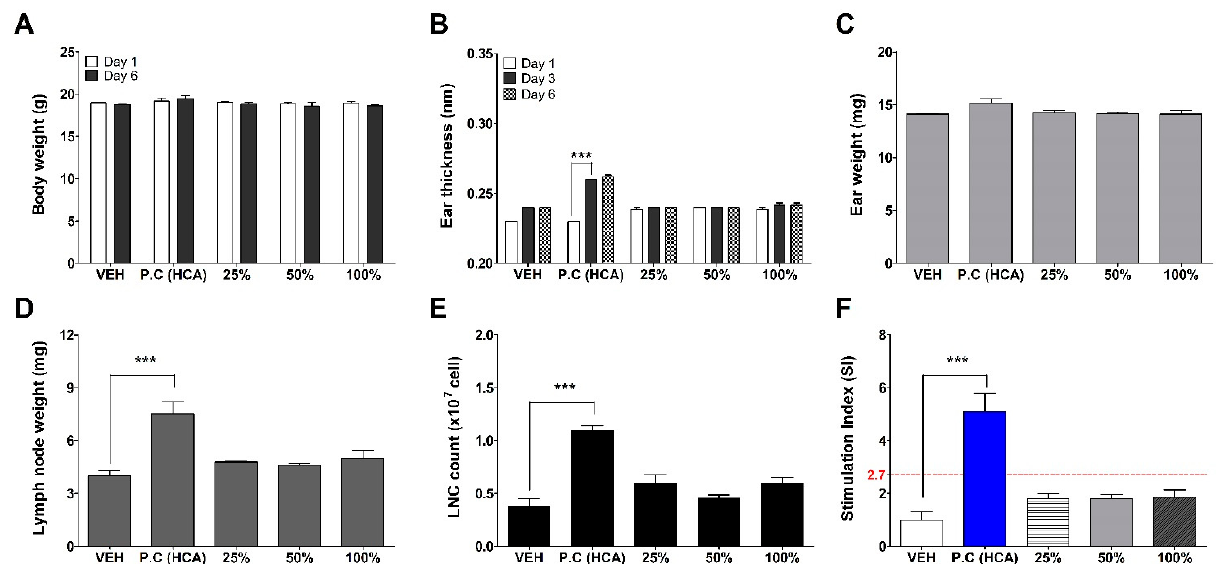
Figure 4. Results of GNPs skin sensitization potential in LLNA: BrdU-FCM. The evaluation parameters were as follows: ( A ) Body weight (g), ( B ) Ear thickness (mm), ( C ) Ear weight (mg), ( D ) Lymph node weight (mg), ( E ) Lymph node cell (LNC) count (×10 7 cells), and ( F ) Stimulation Index (SI). Data are expressed as mean ± SEM ( n = 4). Each treatment group was compared with the vehicle control group to determine statistical significance. *** p < 0.0001.